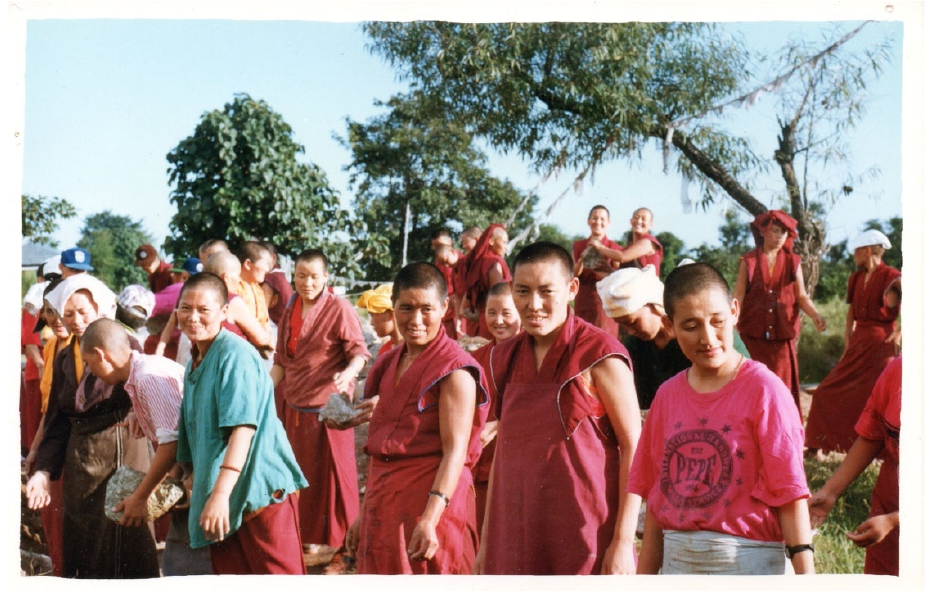
Figure 1. Nuns from Dolma Ling participated in the construction of their nunnery (1996).